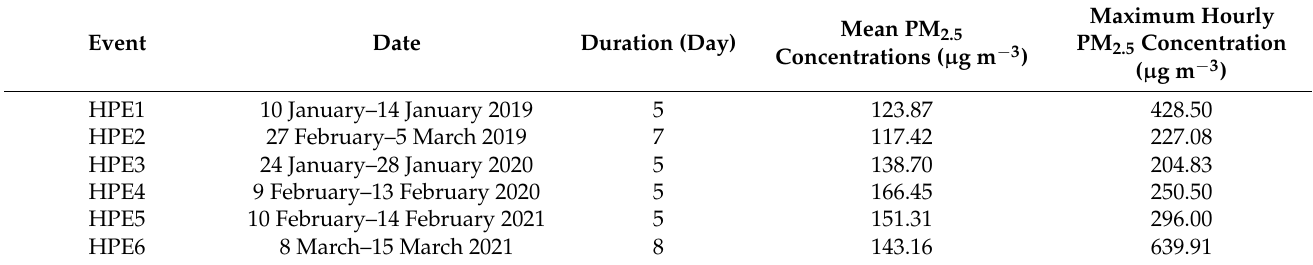
Table 2. Six heavy PM 2.5 pollution episodes (HPEs) in Beijing pre- to